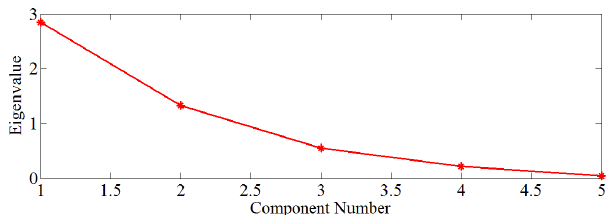
Fig. 8. Scree plot of total variance explained.